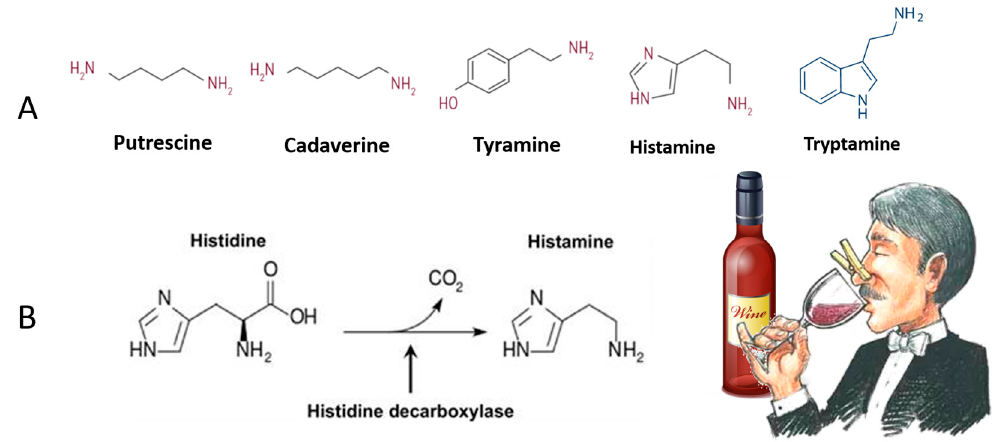
Figure 3. Biogenic amines (BAs) in wine that, besides being a healthy treat, negatively affect the aromatic quality of wines owing to their unpleasant smells ( A ). The decarboxylase enzyme transforms amino acid into a biogenic amine by removing its carboxyl group. The example presented is the formation of histamine ( B ).